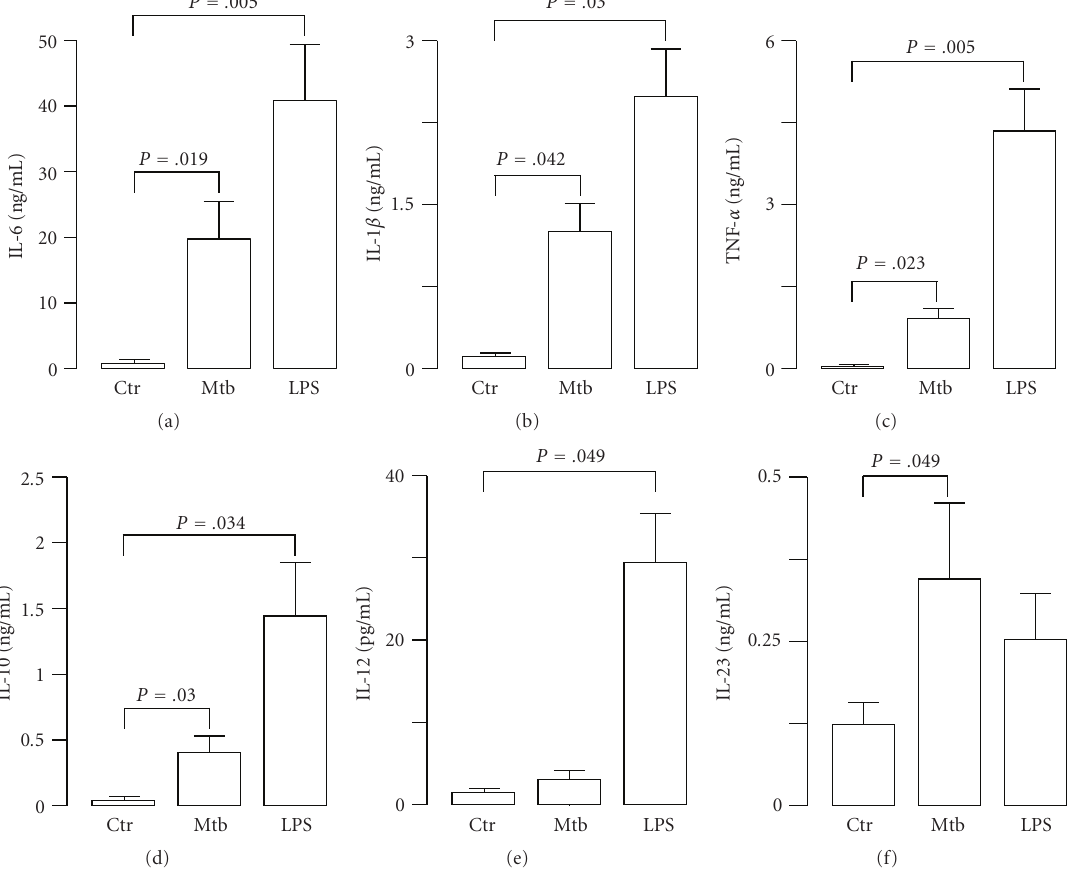
Figure 1: Cytokine production in Mtb-infected or LPS-treated human monocytes. Monocytes were infected with Mtb (MOI = 1) or treated with LPS (1 μ g/ml). After 24 hr cell culture supernatants were collected and determination of cytokine content was performed by CBA or ELISA. The results represent the mean ± SE of four separate experiments performed with di ff erent donors.